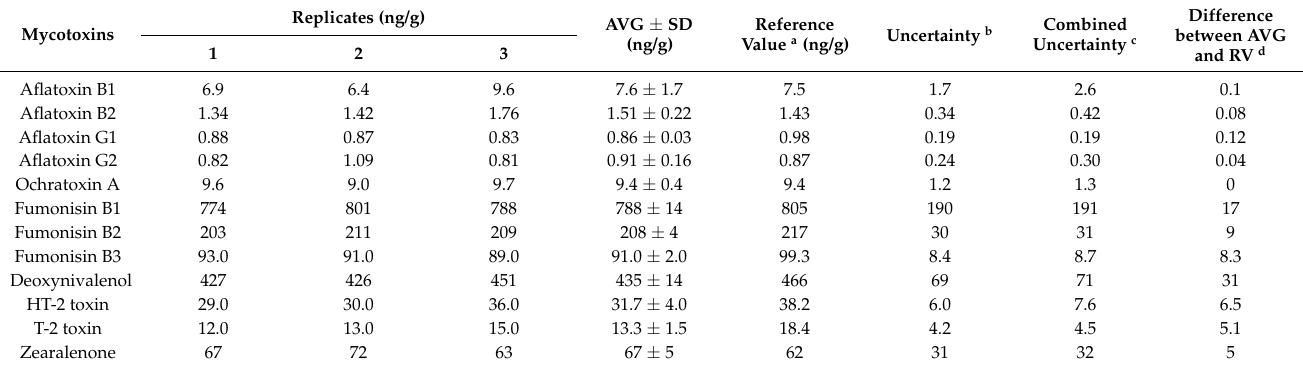
Table 1. LC–MS analysis of three replicates of SRM